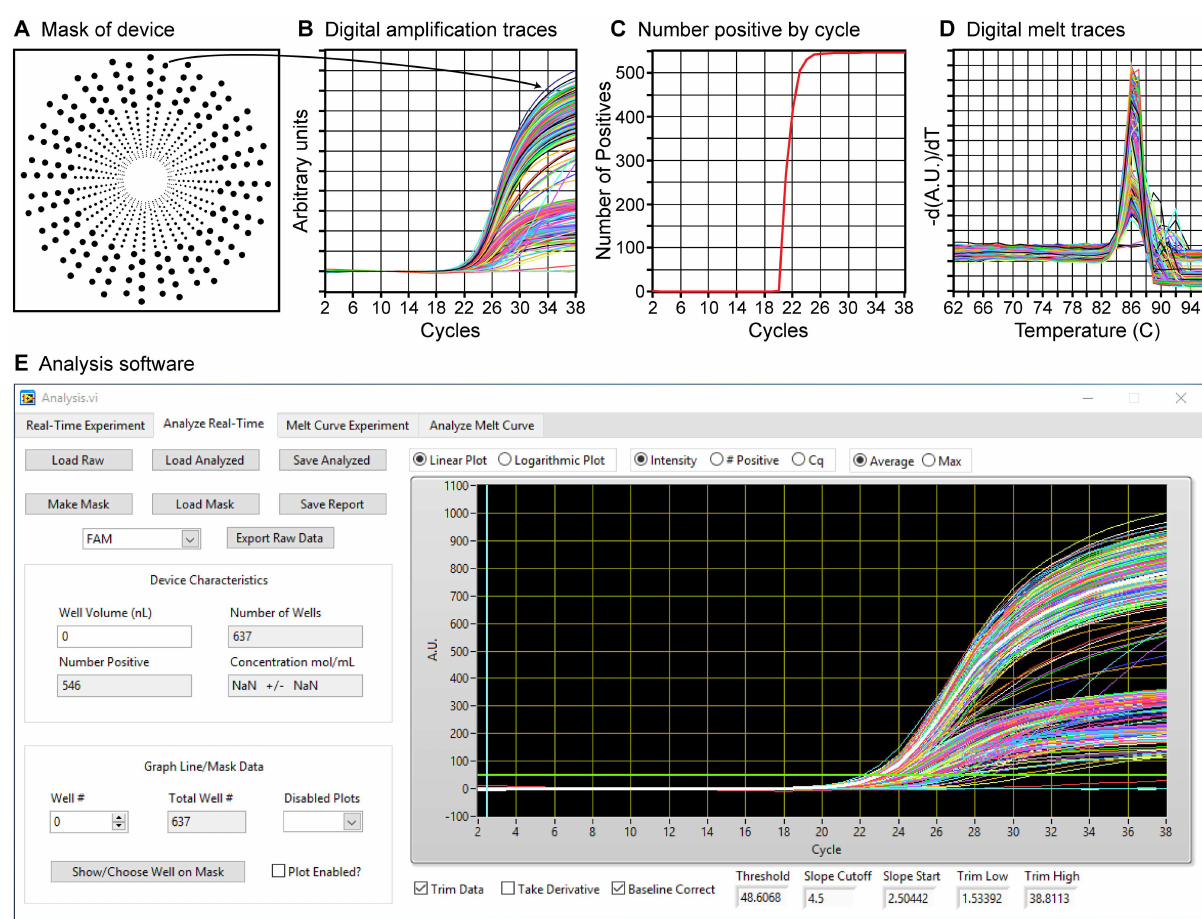
Fig 5. Types of data output provided by the custom analysis software of the real-time digital nucleic acid amplification instrument after a multivolume PCR reaction using lambda DNA on a multivolume SlipChip device with a 15 s exposure time. Each graph (B–D) was exported as line art and scaled. (A) An image depictingthe mask created to define the locationsof each compartmentalizedreaction on a multivolumemicrofluidic device. (B) Baseline-corrected amplification traces from each of the reaction wells on the microfluidic device. Two intensity groups result because in this multivolume microfluidic device there are two well depths (the two larger volumes are 100 μ m deep and the two smaller volumes are 50 μ m deep) [20]. The arrow shows the correlationof a single compartmentalizedreaction (A) to its real-time trace (B). (C) A graph depictingthe number of positive reactions as a function of amplification cycle from the data generated in (B). (D) A graph depictingthe negative derivative of the collectedmelt curve traces from each of the positive reactions. (E) A screenshot of the analysissoftware analyzing the real-time data shown in panel